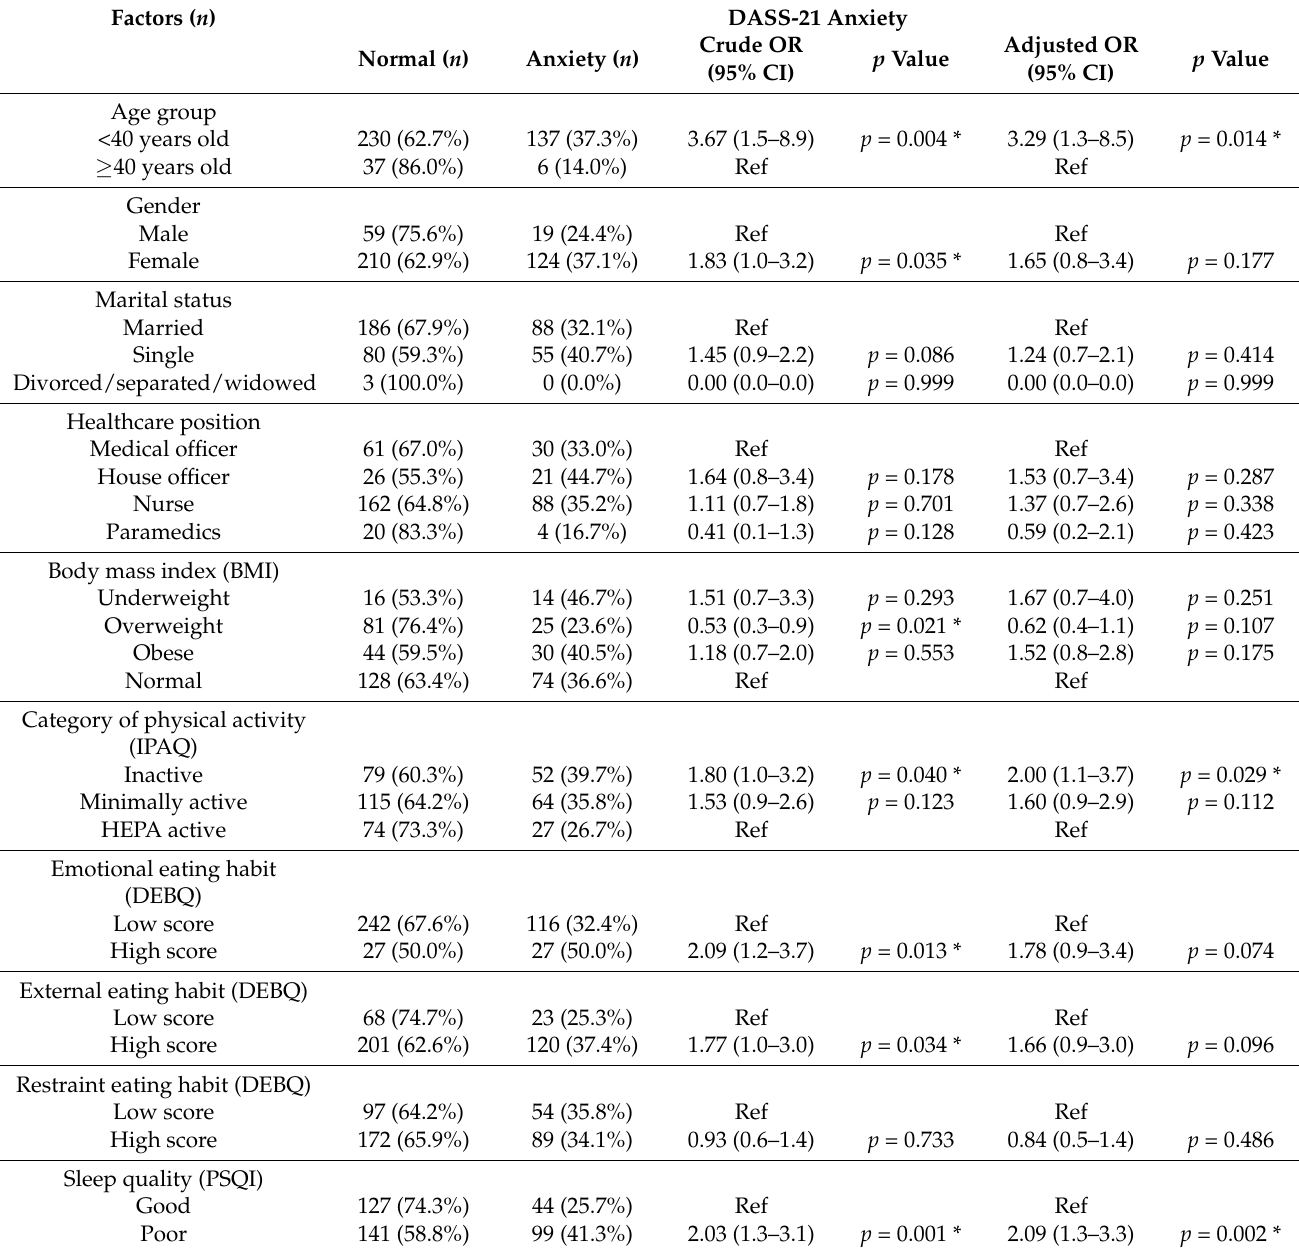
Table 4. The crude odds ratio (OR) and adjusted OR (AOR) for DASS-21 of